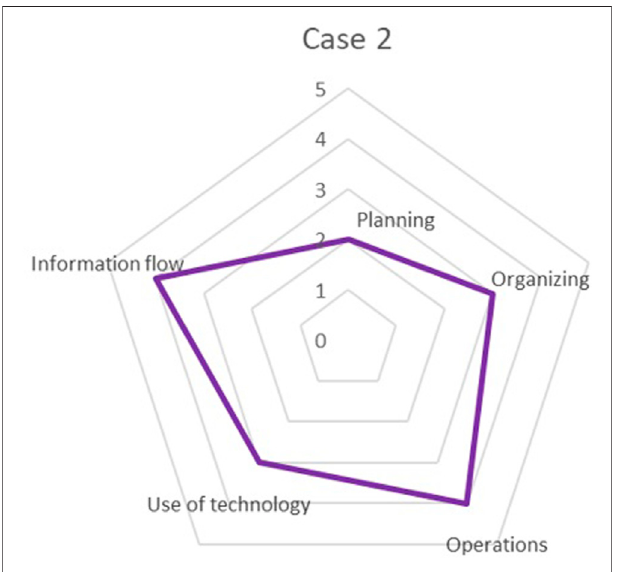
FIGURE 4 | Case 2 ’ s logistics maturity assessment.